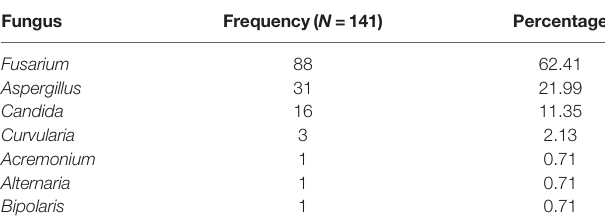
TABLE 6 | The spectrum and frequency of various fungi isolated from pediatric patients with fungal keratitis and identi fi ed at the genus level during 1990 to 2020 (141 out of 163 isolates have been identi fi